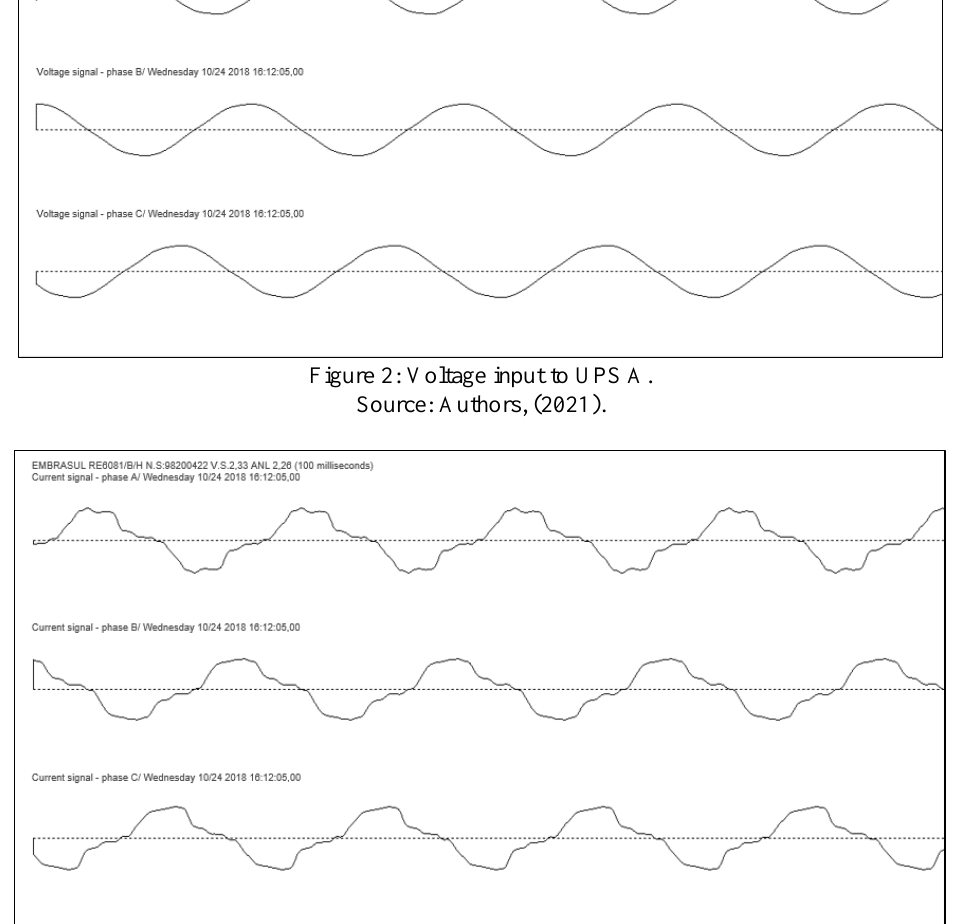
Figure 3: Current input to UPS A.